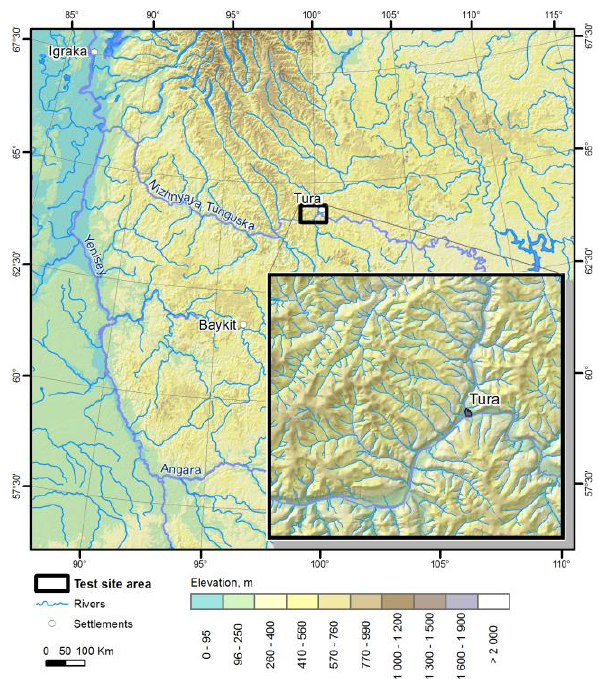
Figure 1. Location of the test site